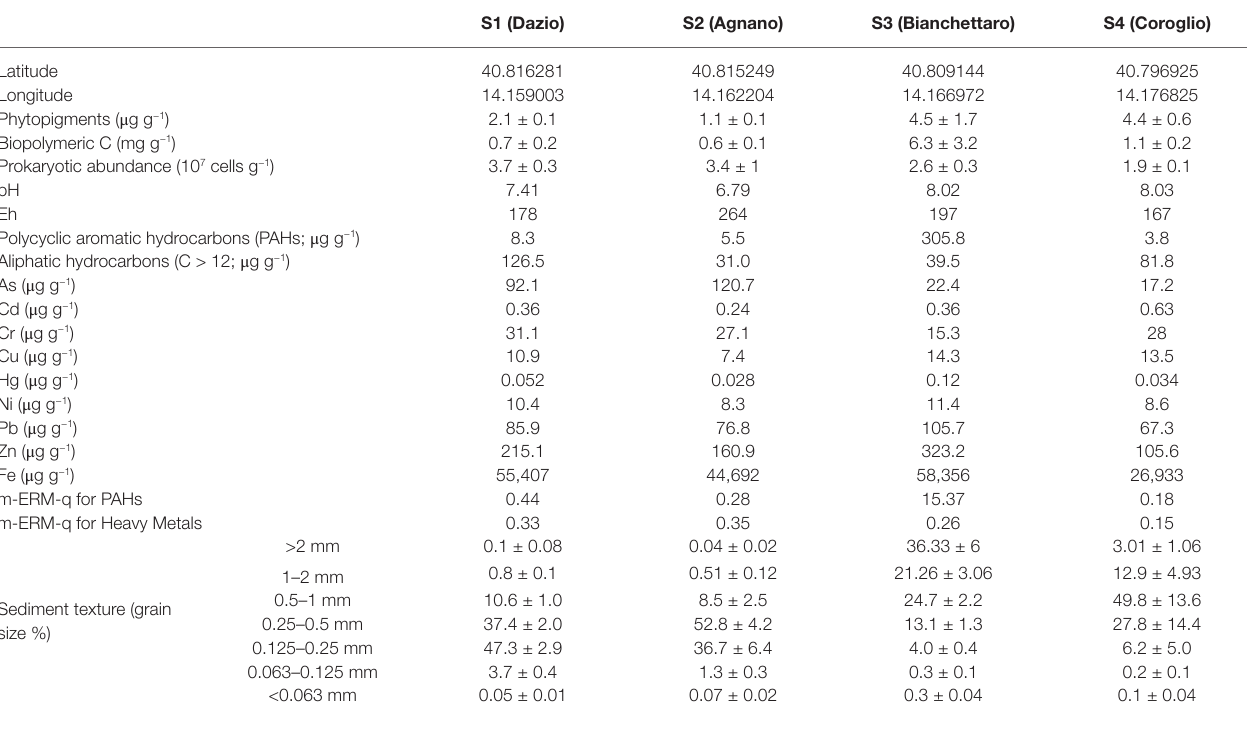
TABLE 1 | Environmental, chemical and microbiological variables at the four benthic stations of the Bagnoli-Coroglio area.